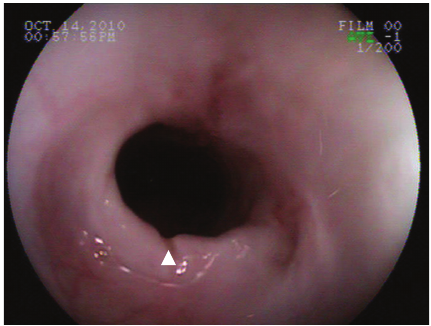
Figure 3: Endoscopic appearance of the esophageal stricture at re- examination on day 60, oneweek after cutting balloon dilation. Note the persistent defect in the fibrous band (white